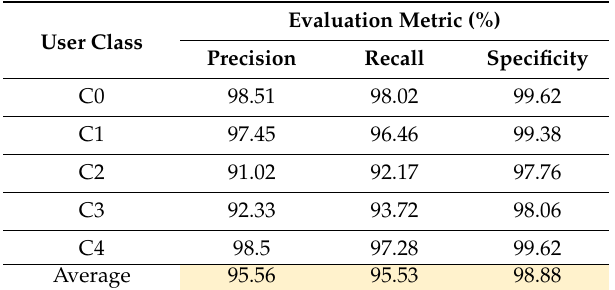
Table 5. Performance metrics for classification